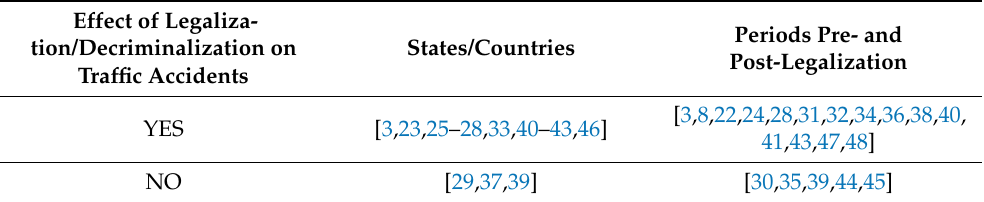
Table 7. List of articles used in the review according to legalization period, state or country, and effect of